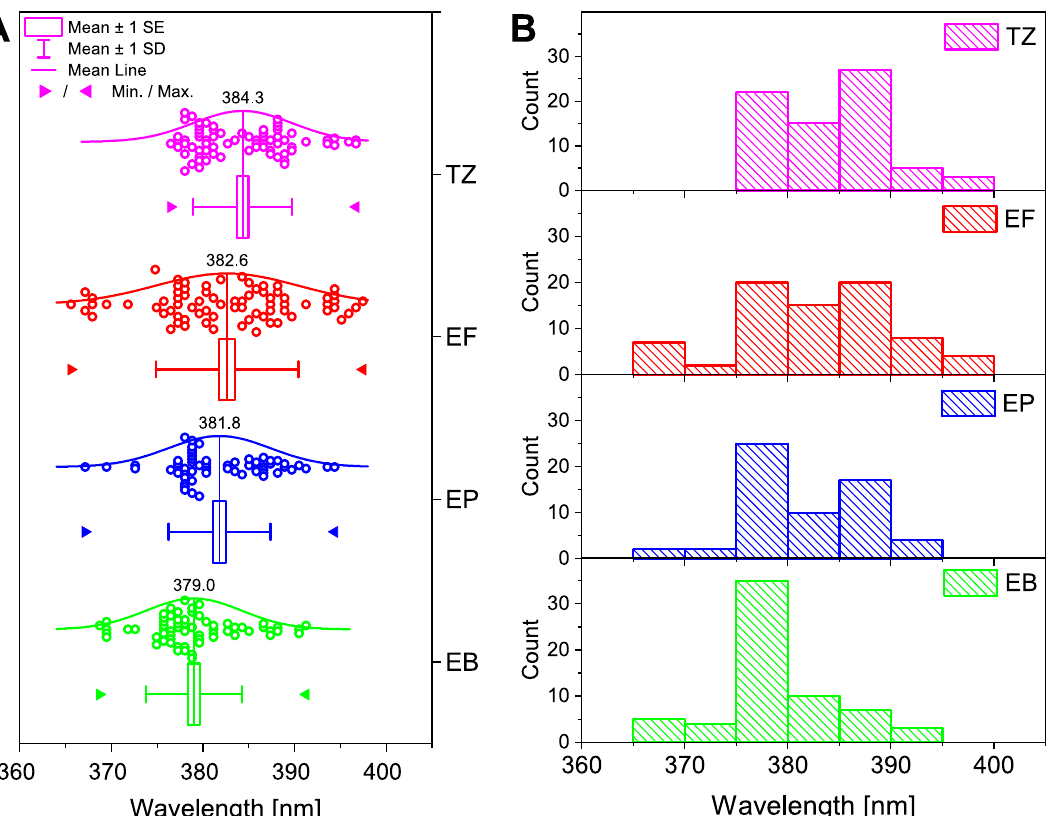
Figure 2. Cumulative presentation of the spectral position of the blue reflectance maximum for all four wings of male Polyommatus icarus butterflies. ( A ) The four sampling sites: TZ: Taizé (Burgundy, Southern France, August 2017); EF: Érd-1 (Central Hungary, May and August 2018); EP: Érd-2 (Central Hungary, May and August 2018); EB: Baraţcoş (Eastern Carpathians, Romania, July 2017). ( B ) Histograms of the spectral position of the blue reflectance maximum of the same